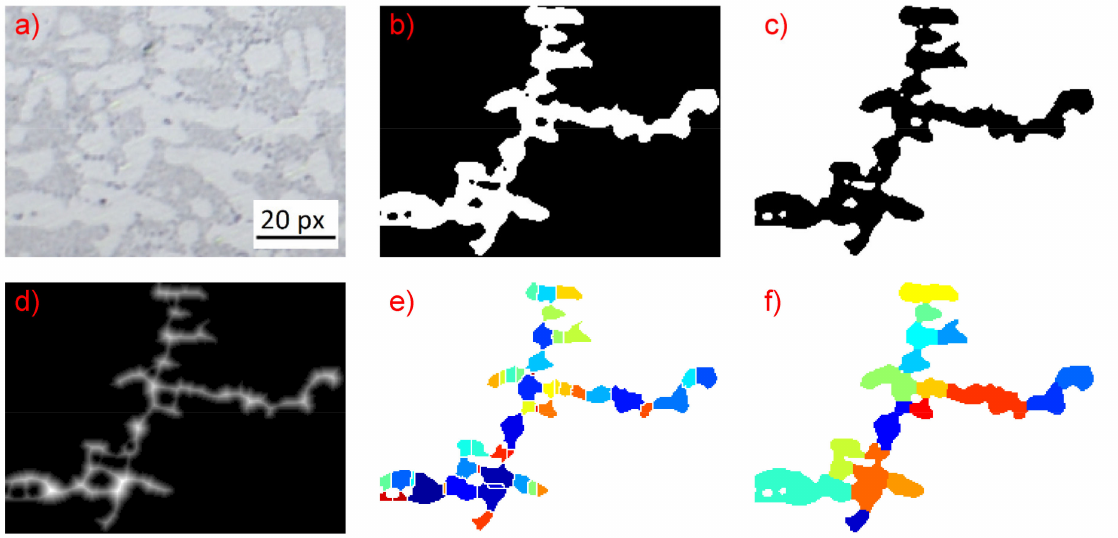
Figure 2. Procedure for decomposing of complex objects; ( a ) crop of the original micrograph showing a complex dendritic scheme. ( b , c ) Binarization of the dendritic scheme. ( d ) this approach shows a tendency for over-segmentation of the image. ( e ) In order to resolve this issue, a post-processing step is required that merges the individual watershed regions in such a way that the individual dendrite arms can be identified. To this end, neighborhood relations are defined for all watershed regions on the basis of a 4/8-connected neighborhood. ( f ) Afterwards, a procedure is initiated that aims at merging two neighboring watershed regions to a single